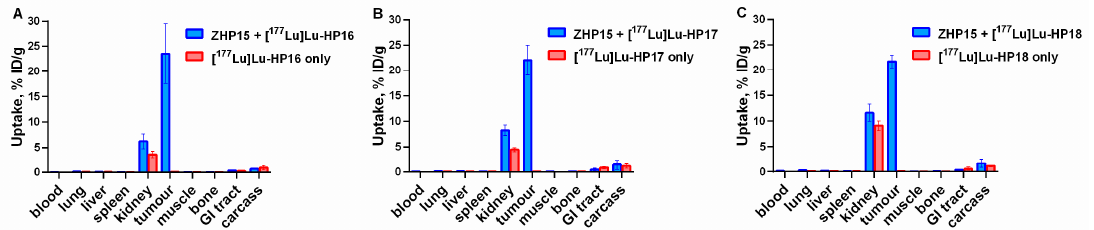
Figure 6. Biodistribution of ( A ) [ 177 Lu]Lu- HP16 , ( B ) [ 177 Lu]Lu- HP17 , and ( C ) [ 177 Lu]Lu- HP18 at 4 h after injection in female Balb/c nu/nu mice bearing SKOV3 xenografts, with and without preinjection of Z HER2:342 -SR- HP15 . The uptake is expressed as % ID/g and presented as an average ± SD ( n = 5).